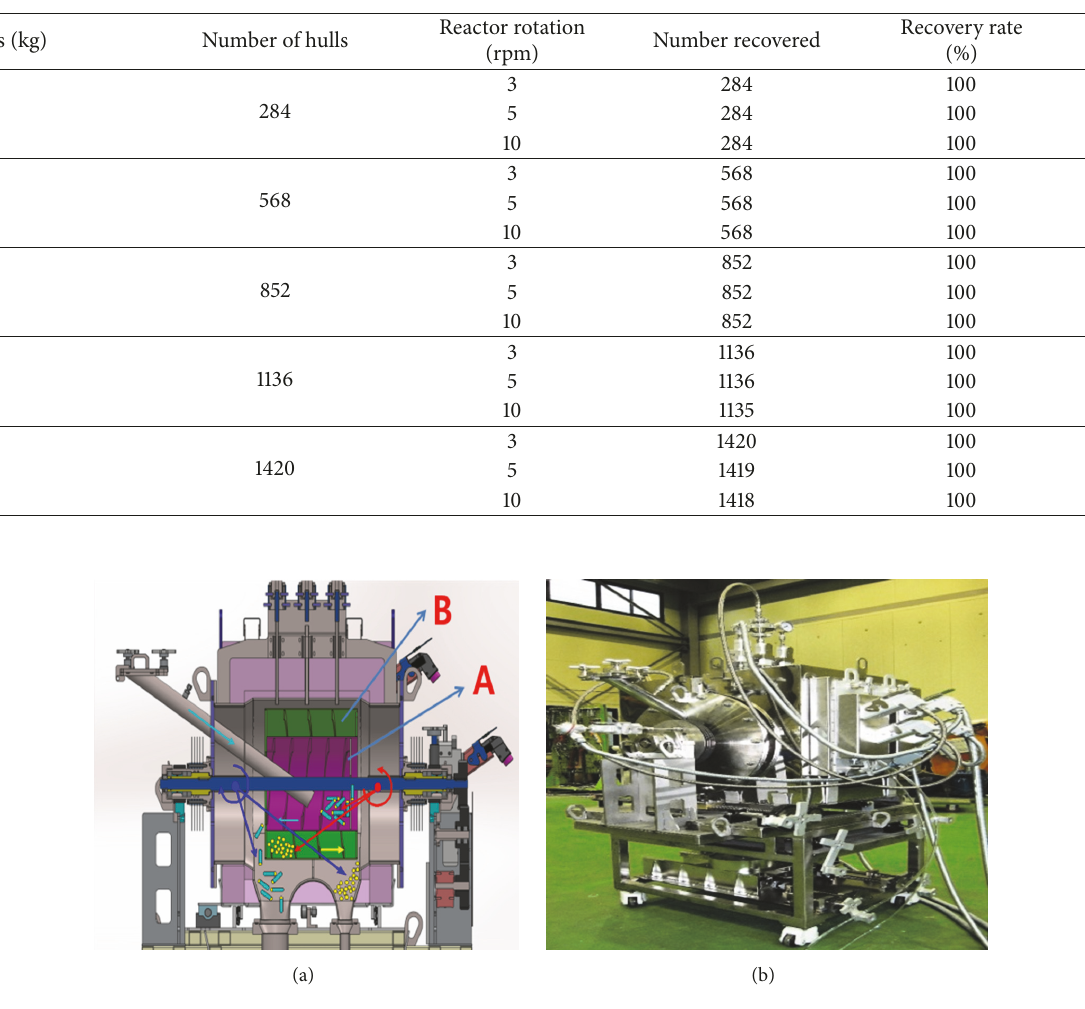
Figure 16: Optimized reactor and device: (a) double reactor; (b)